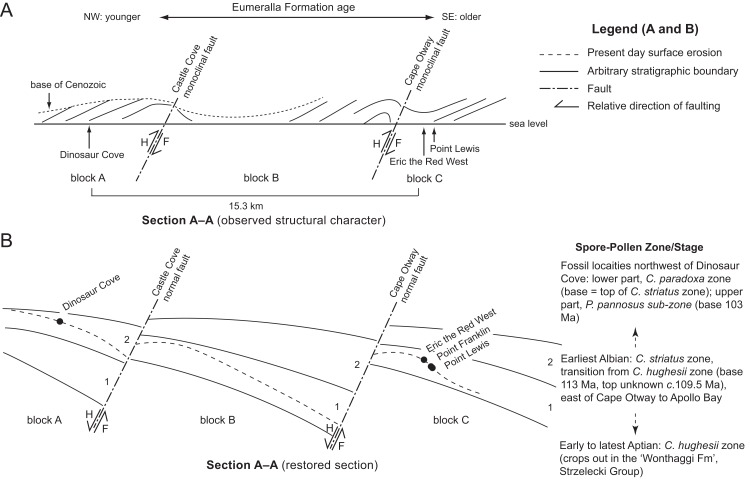
Schematic stratigraphic relationships of the Eumeralla Formation fossil vertebrate localities looking northeast along section ‘A–A’ (Fig. 1B).(A) Present-day structural geological features. (B) Restored section for the early Albian (stratigraphic age estimates following Helby, Morgan & Partridge, 1987; Gradstein, Ogg & Schmitz, 2012; Wagstaff, Gallagher & Trainor, 2012; Korasidis et al., 2016). Stratigraphic zones ‘1’ and ‘2’ in (B) are arbitrary surfaces for reference between faulted blocks. Dashed line in (B) indicates present day coastal margin. Taxon abbreviations: C. paradoxa, Coptospora paradoxa; C. striatus, Crybelosporites striatus; C. hughesii, Cyclosporites hughesii; P. pannosus, Phimopollenites pannosus. Geological abbreviations: F, footwall; H, hanging wall. Horizontal scale approximate and vertical scale exaggerated.